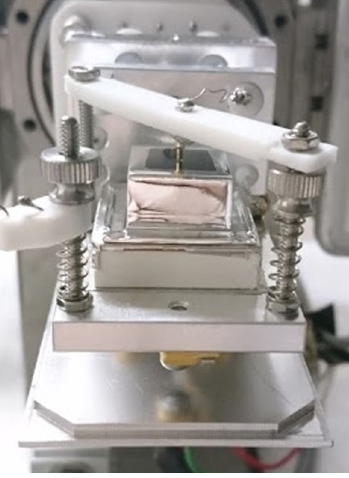
Fig. 6 Shown is the detector USD-W06 loaded in a variable- temperature cryostat for characterization